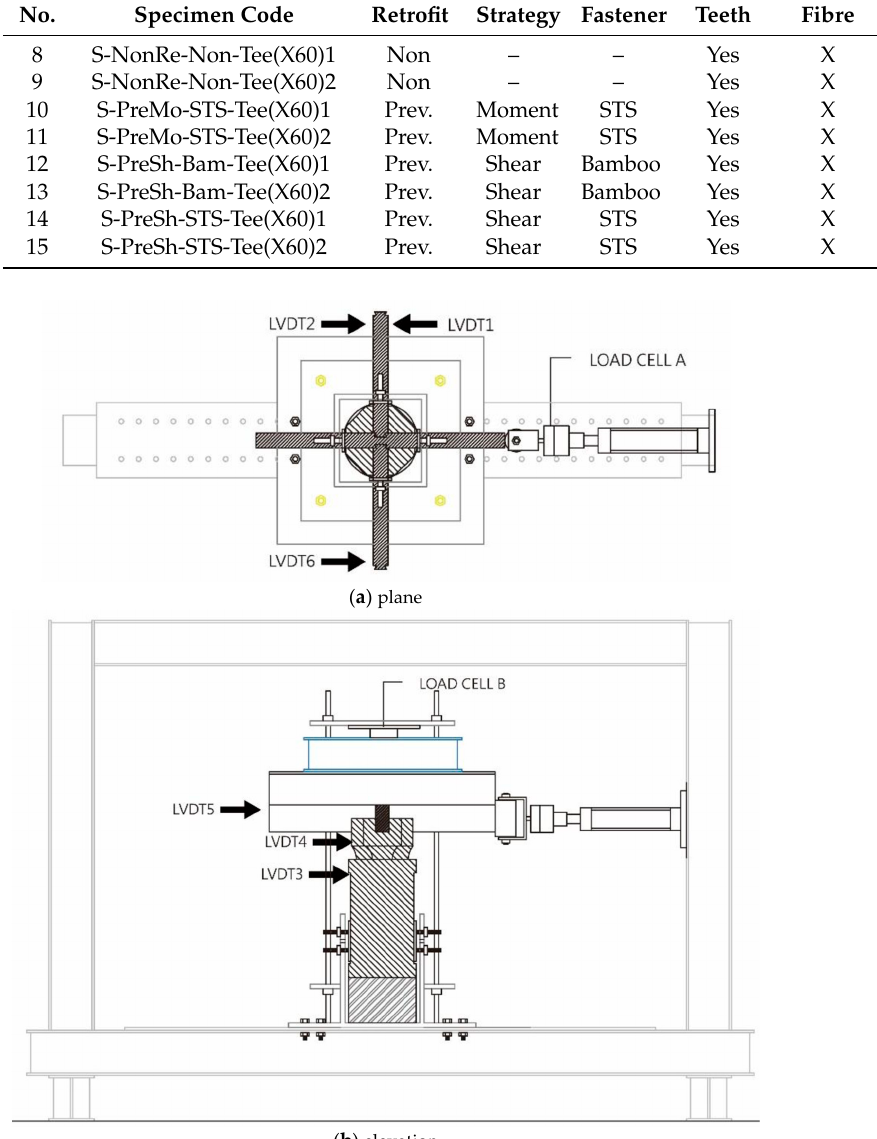
Figure 10. Testing rig of shear test.